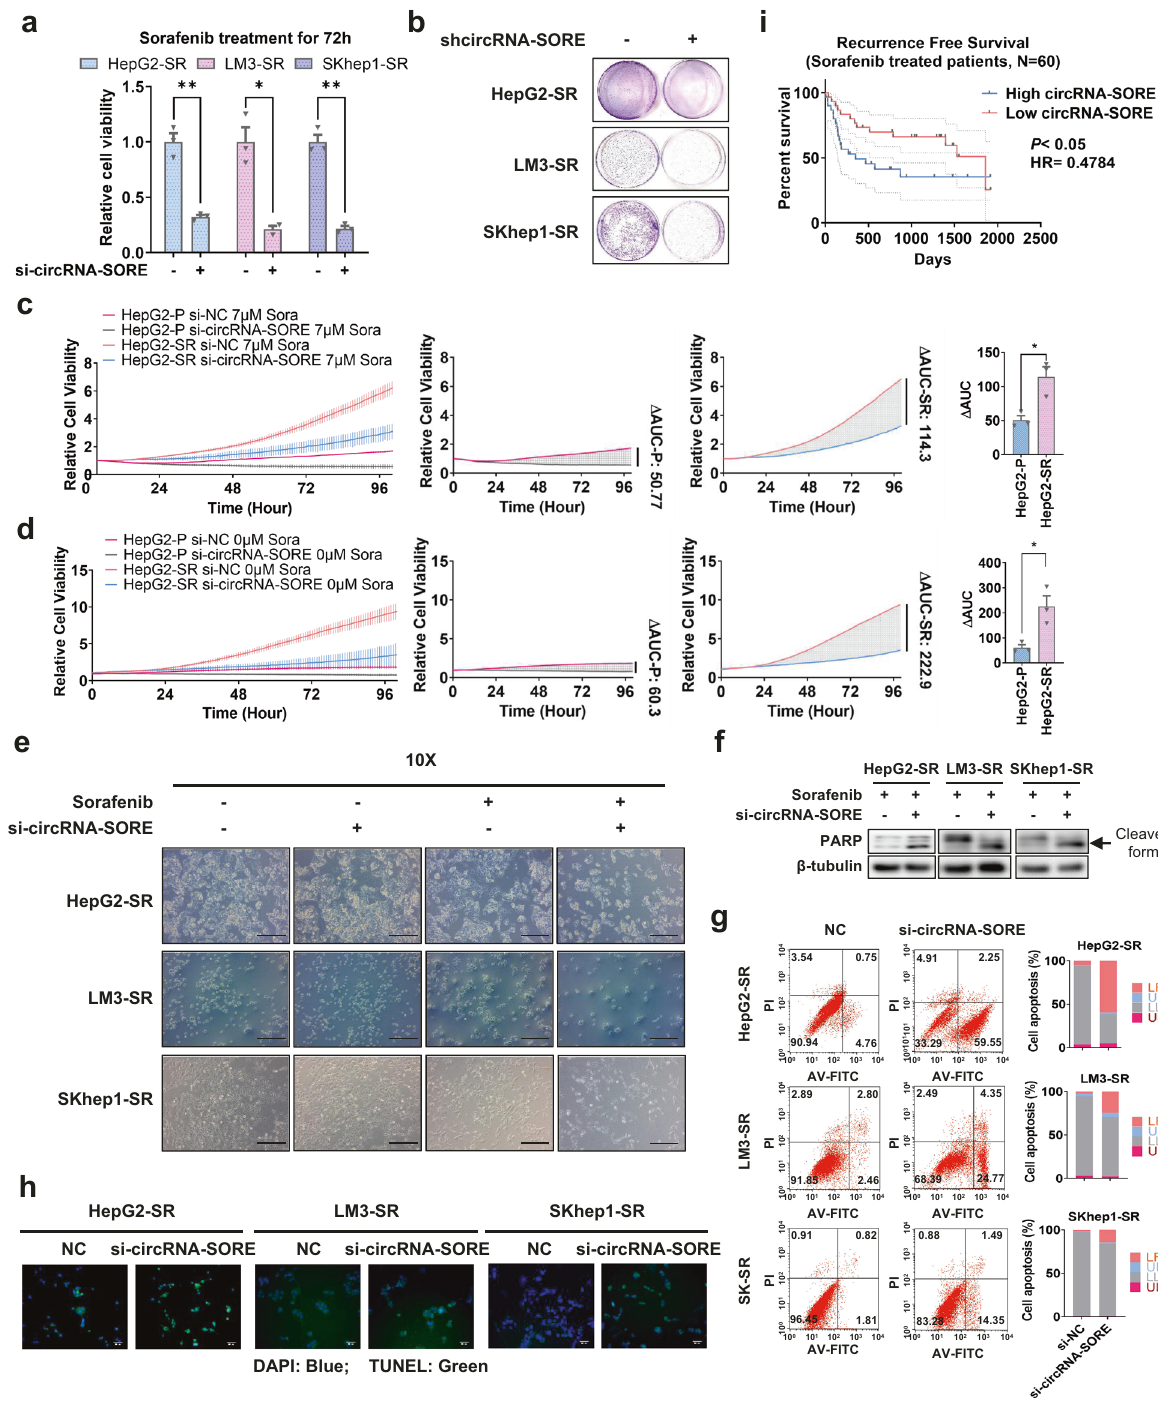
analysis on lysates from circRNA-SORE-silenced HepG2-SR cells and compared it with the control cells, which identi fi ed 129 upregulated and 301 downregulated proteins (fold change > 2 and p < 0.05) (Fig. 3b). Gene Ontology Analysis of the dysregulated proteins in circRNA-SORE-silenced HepG2-SR cells indicated that these proteins are associated with a variety of functions, such as response to drug, cell adhesion and cell migration (Supplementary Fig. 2H). Venn analysis of the circRNA-SORE pull-down proteins and the dysregulated proteins in the circRNA-SORE-silenced group led to the identi fi cation of ten overlapping proteins